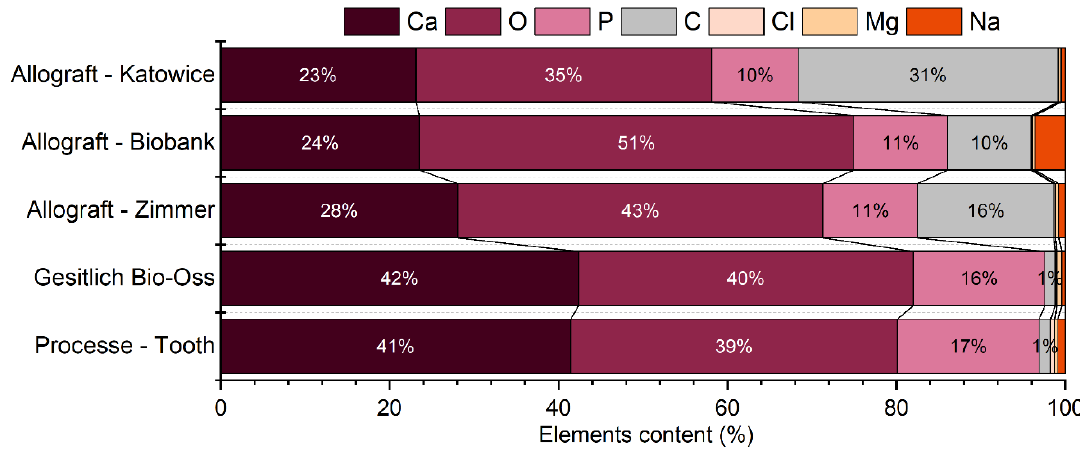
Figure 6. Chemical elements content of investigated materials